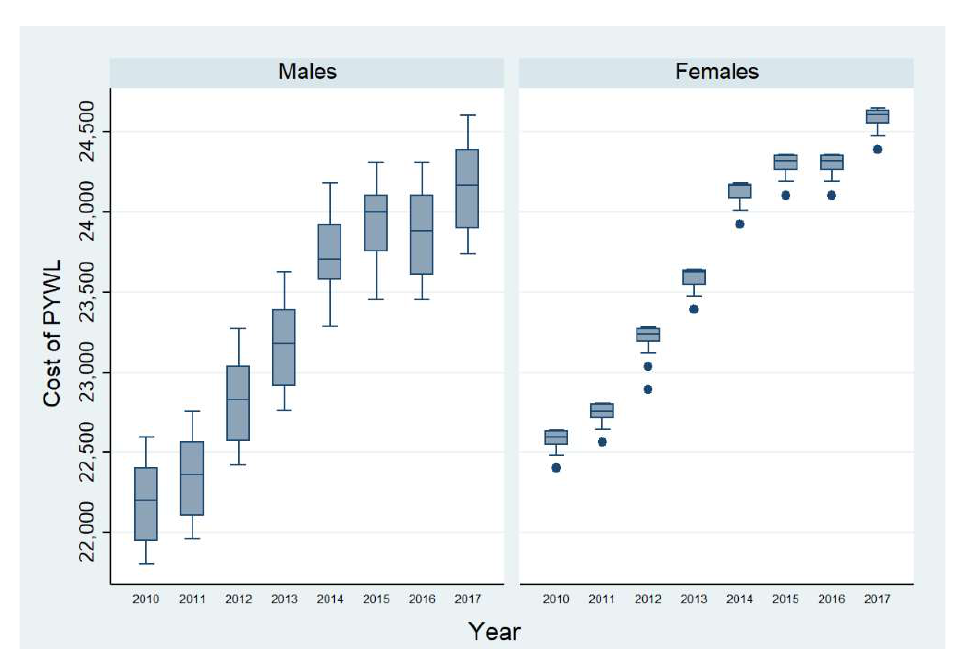
Figure 1. Cost of productivity lost due to premature mortality by sex (USD 2017). Figure 2 depicts the PYWL per occupational group; construction workers, farm work- ers and unskilled workers were the groups with the most years lost. In the graph, the circles are outlier values of the cost of PYWL in farm